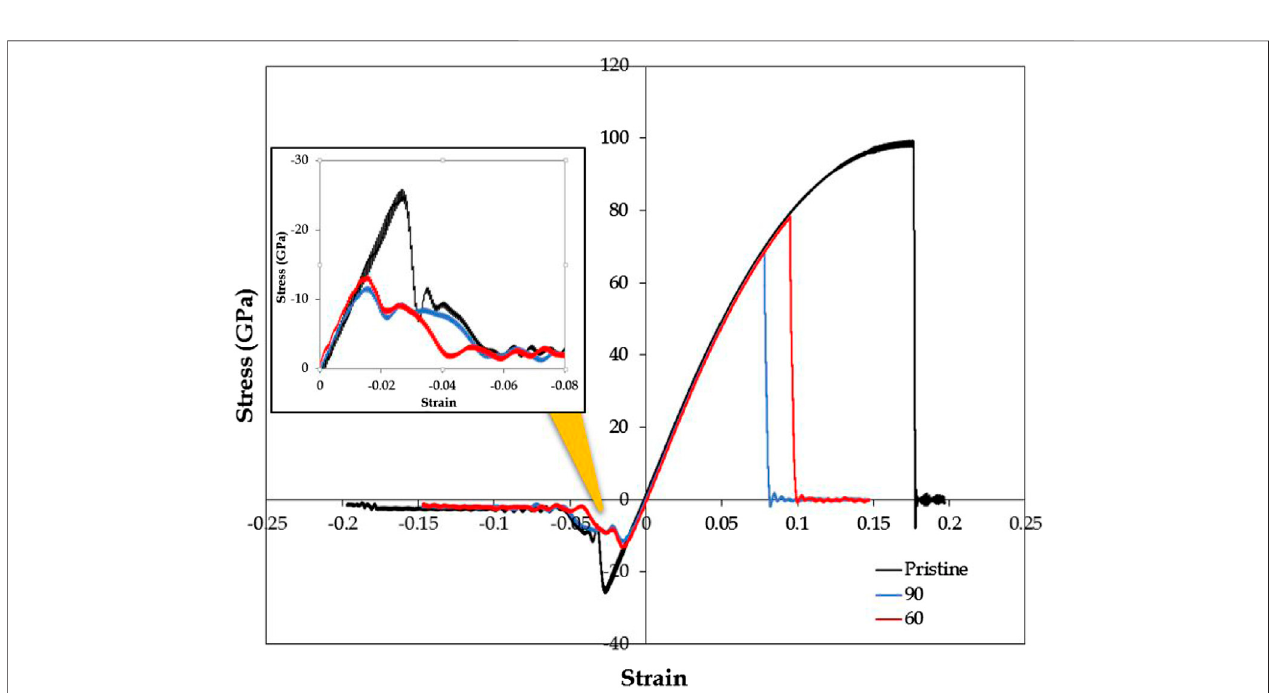
FIGURE 13 | Stress-strain curve of a 3T-junction compared with the same size pristine SWCNT (at 1 K).